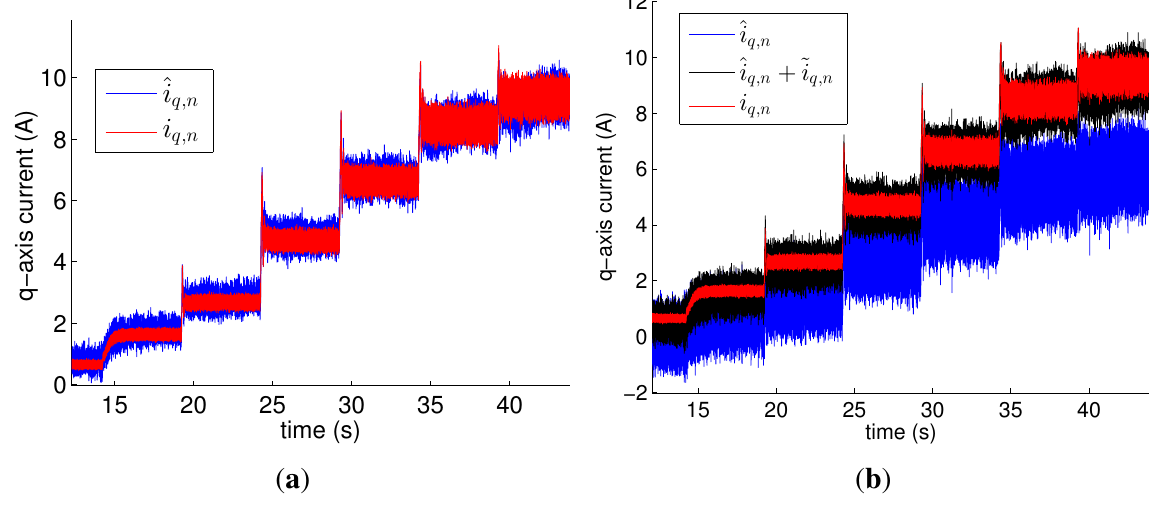
Figure 6. Measured values of q -axis current ( i ( ˆ i ) obtained by open-loop observer for i q,n ( b ) wrong values such as L (cid:48) healthy motor ran at 4500